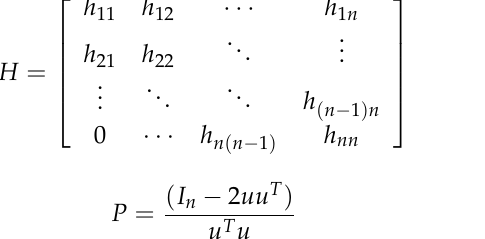
Figure 3. The result of multi-level DCT.